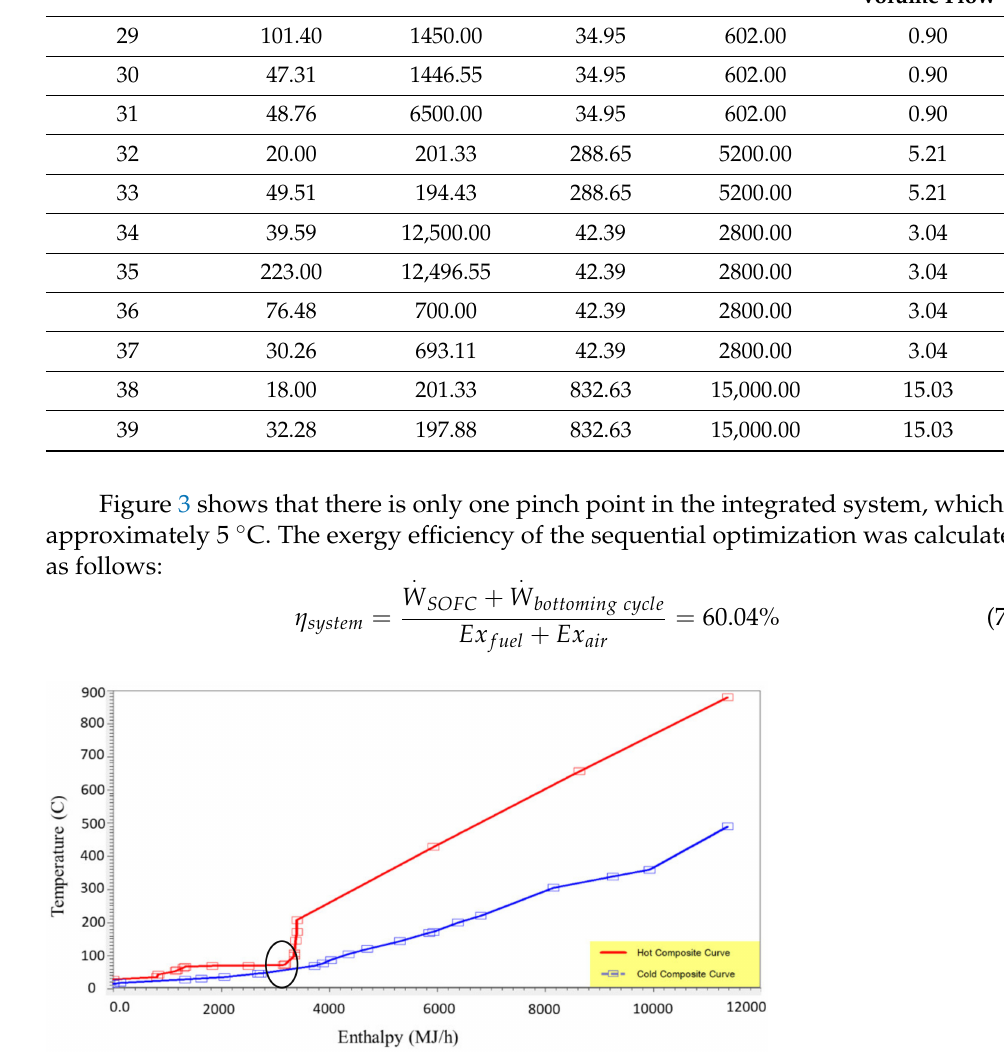
Figure 3. Hot and cold composite curves of sequential optimization for the SOFC–GT–SRC–KC- ORC